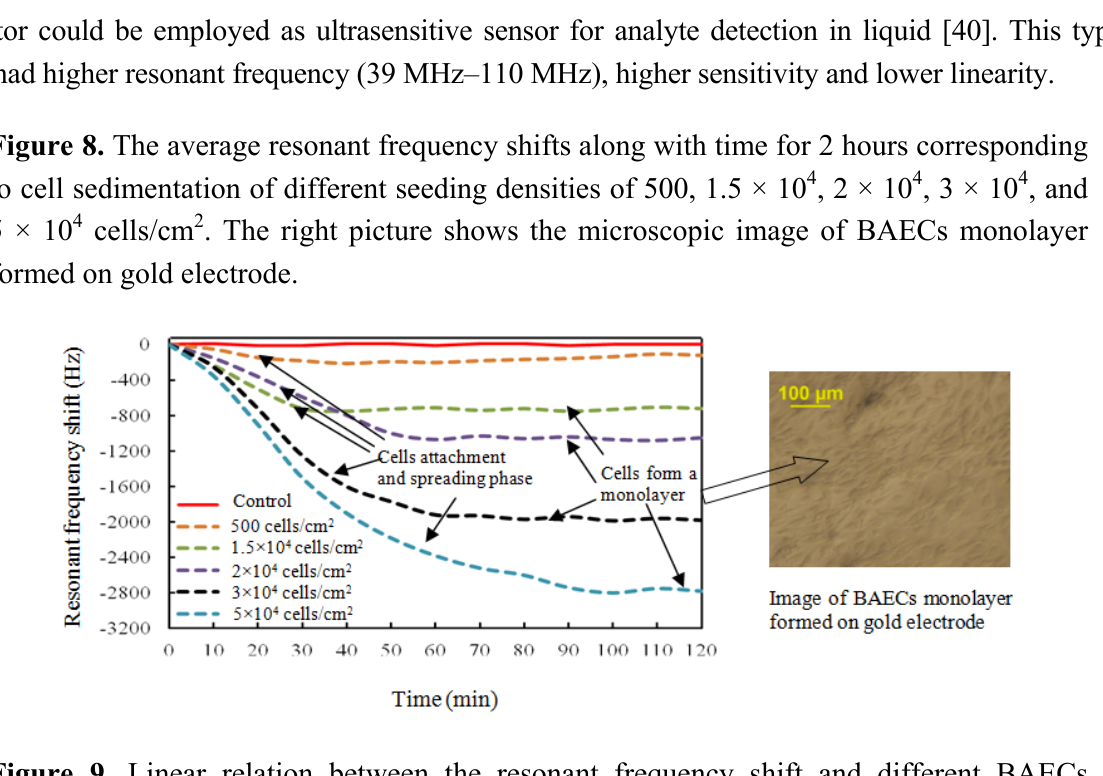
Figure 9. Linear relation between the resonant frequency shift and different BAECs seeding